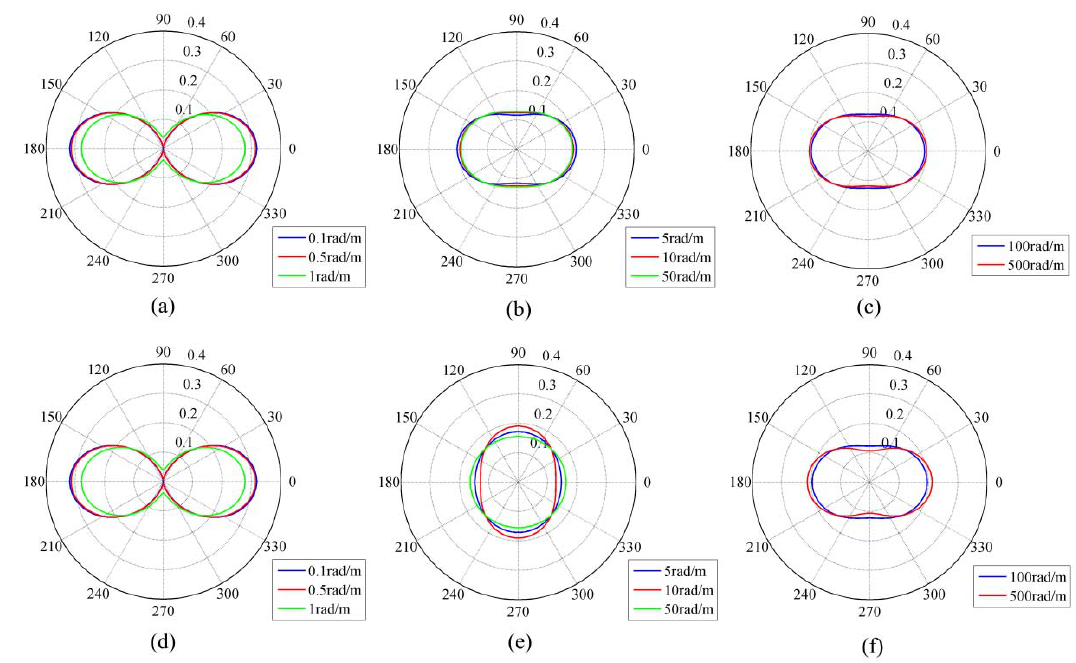
Figure 3. Numerical curves of two angular spreading functions in polar coordinates at 5 m/s wind speed, versus wavenumber k . The upper row represents Elfouhaily ASF, and the bottom row represents our ASF. ( a ) Elfouhaily ASF, 0.1, 0.5, and 1 rad/m wavenumber; ( b ) Elfouhaily ASF, 5, 10, and 50 rad/m wavenumber; ( c ) Elfouhaily ASF, 100 and 500 rad/m wavenumber; ( d ) Our ASF, 0.1, 0.5, and 1 rad/m wavenumber; ( e ) Our ASF, 5, 10, and 50 rad/m wavenumber; ( f ) Our ASF, 100 and 500 rad/m wavenumber.